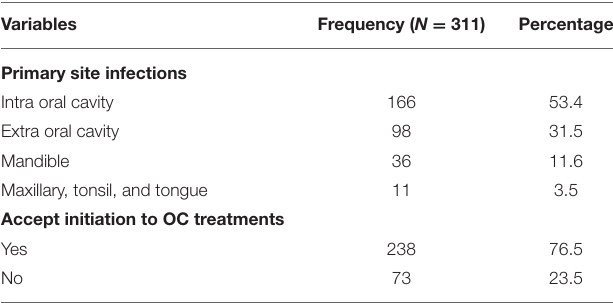
TABLE 2 | Clinical characteristics of the study